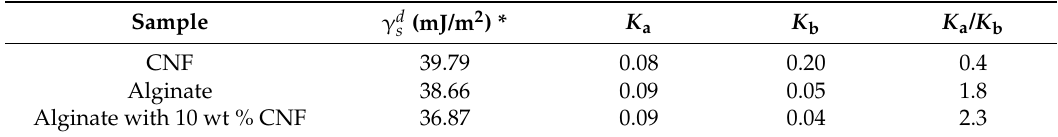
* Correlation coefficient between 0.998 and 0.999.